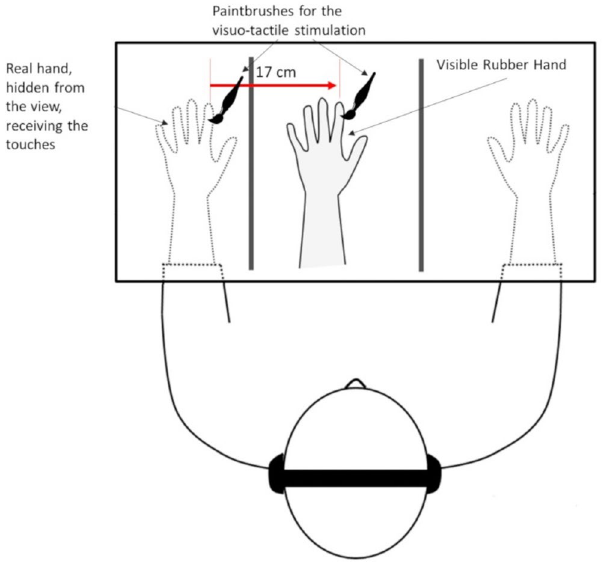
Figure 8. The Rubber Hand Illusion setup is depicted. Only the central compartment was visible during the illusory stimulation. The real hands were not visible during the illusion